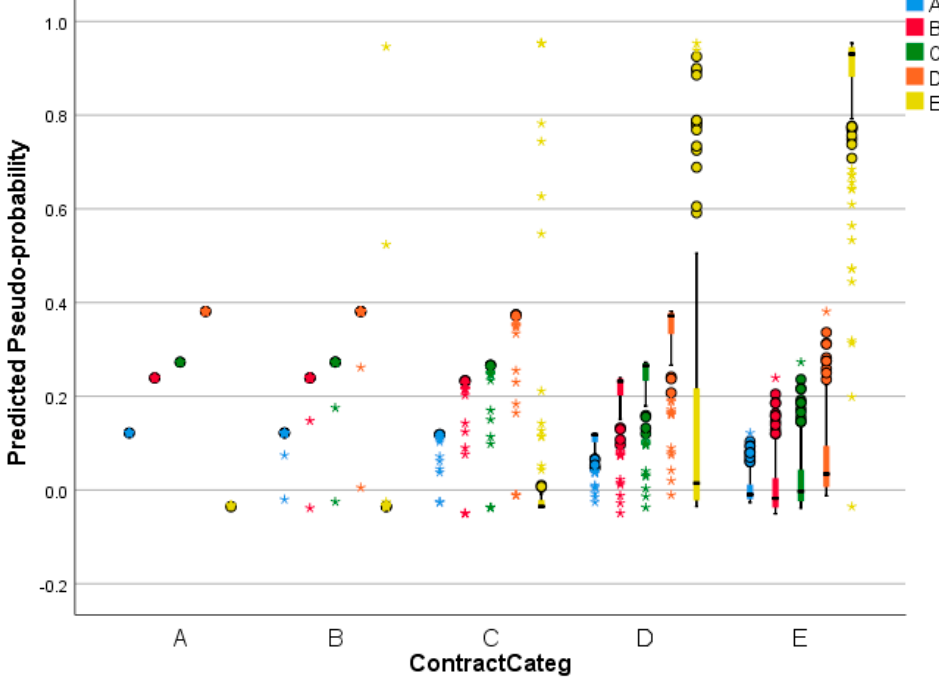
Figure 1. Predicted by the observed chart for ContractCateg.